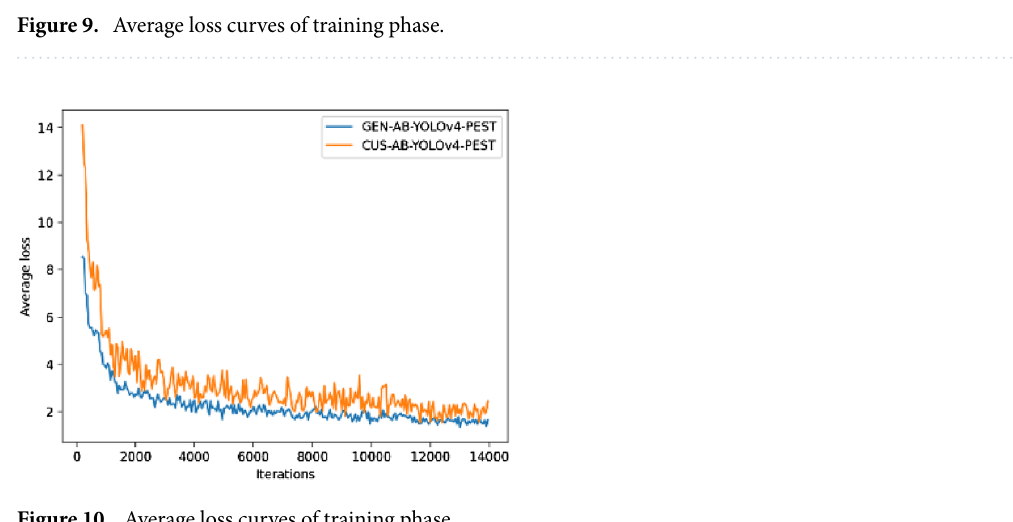
Figure 10. Average loss curves of training